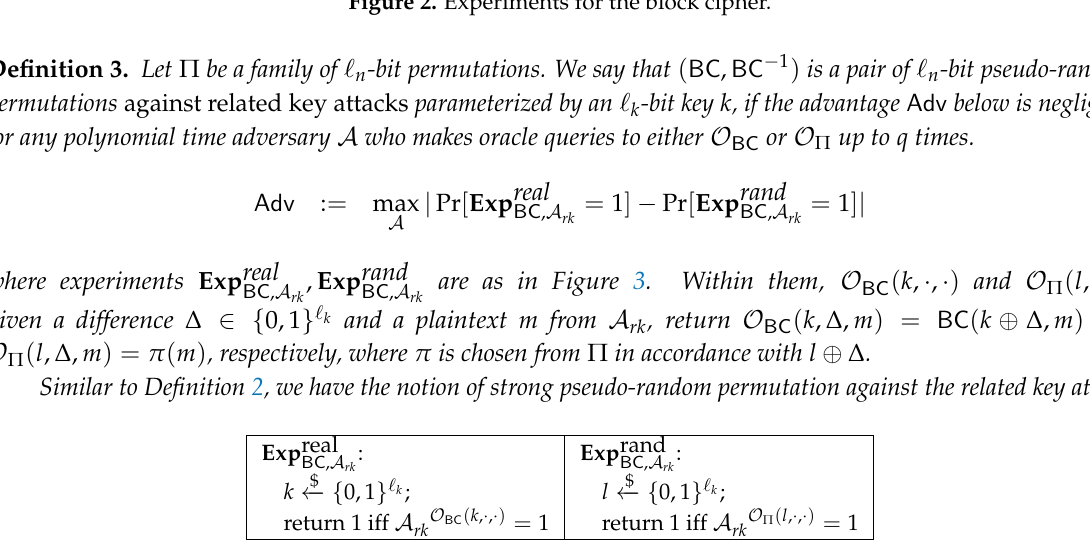
Figure 3. Experiments for the block cipher with related key